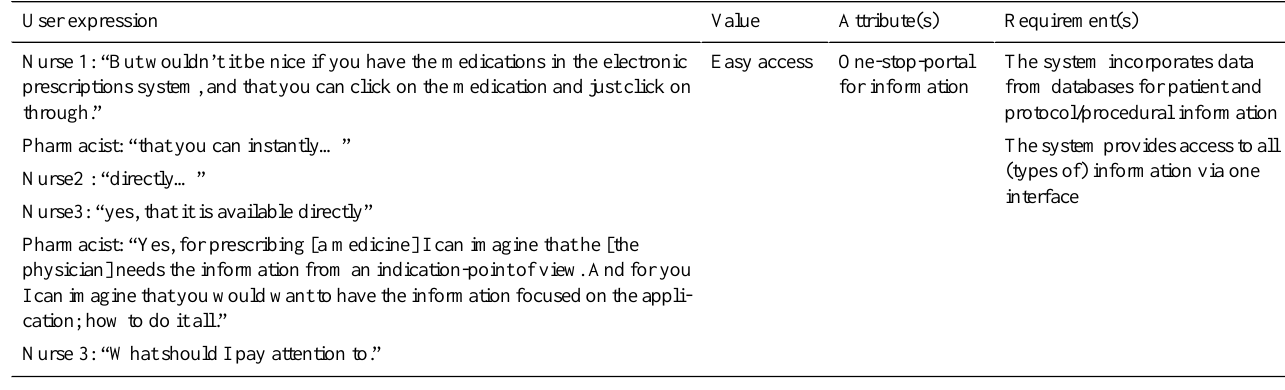
Table 2. Data analysis table for antibiotic stewardship